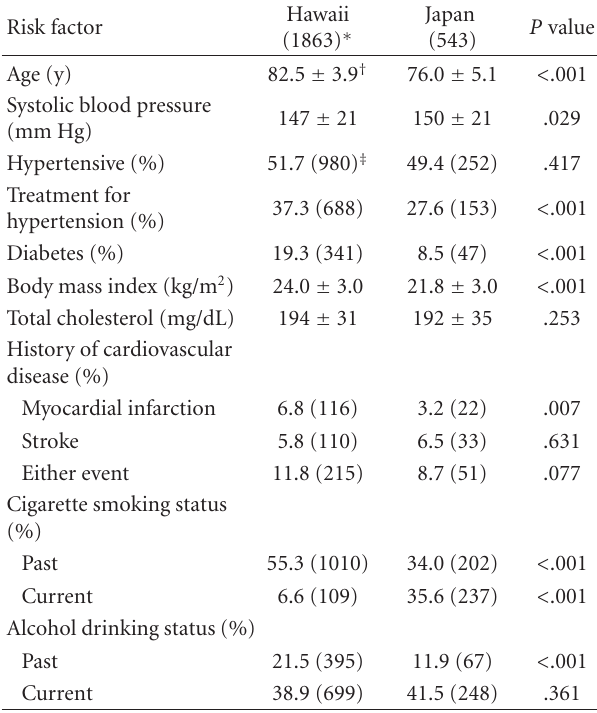
∗ Sample size, † average ± standard deviation, ‡ subjects with the risk